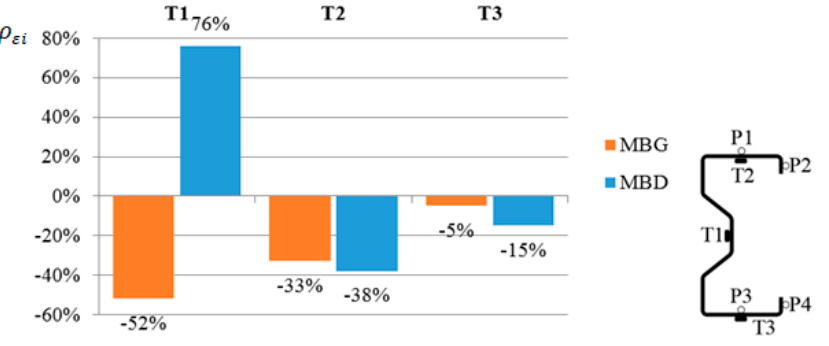
Figure 8. Strain percentage change in relation to the beams without reinforcement, read from a strain gauge at a load level of 25 kN and for different locations of the CFRP tape.